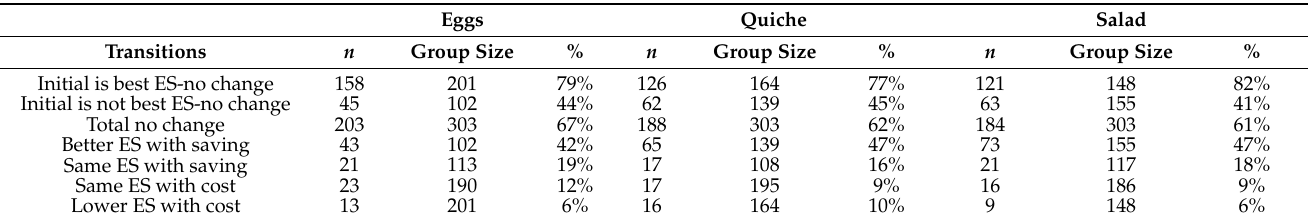
Table 9. Change from the initial choice of type of eggs, by product, after environmental score (ES) information. Eggs Quiche